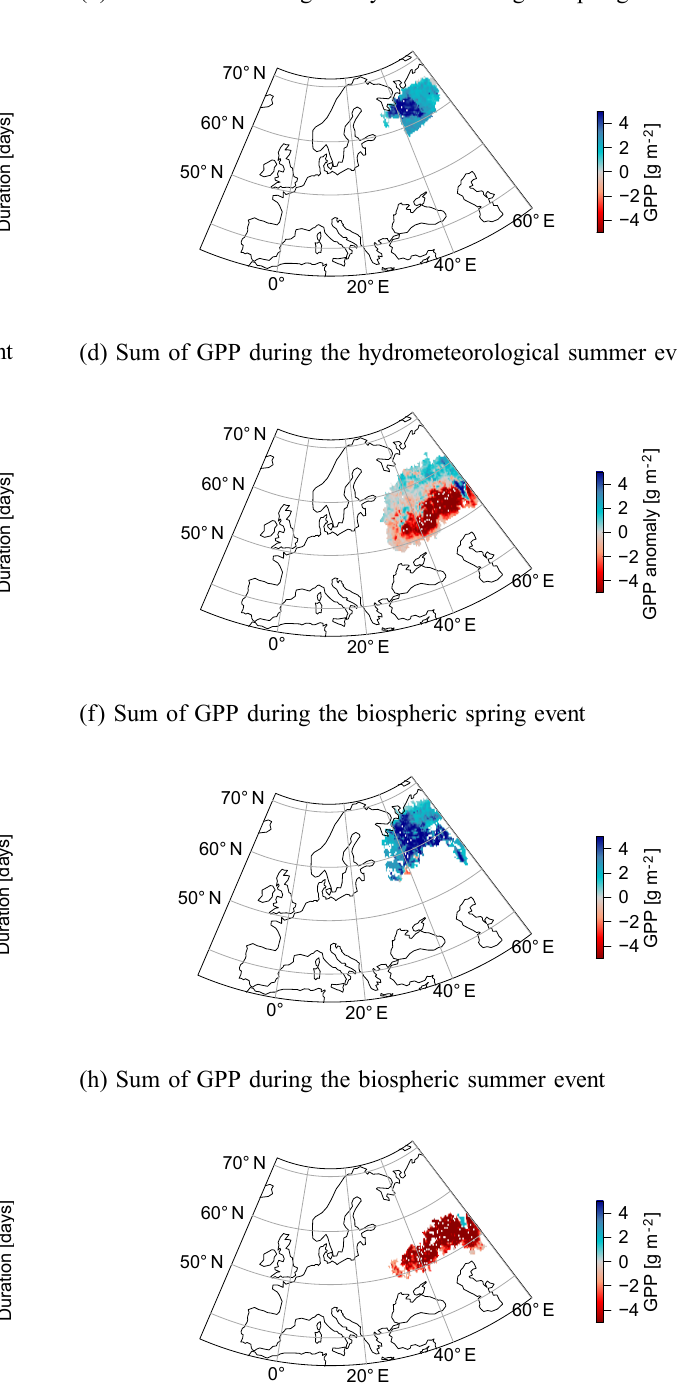
Figure 5. Left column: temporal duration of the (a) hydrometeorological spring event, (c) hydrometeorological summer event, and biospheric 1 events (e, g) . Right column: corresponding GPP response, i.e., the sum of deviations from the seasonal cycle during the event for the (b) hydrometeorological spring event, (d) hydrometeorological summer event, and biospheric events (f, h) . While the GPP response during the hydrometeorological spring event is entirely positive (more productive than usual, b ), GPP response during the hydrometeorological summer event differs between higher latitudes ( > 55 ◦ N, short-lasting, positive) and lower latitudes (long-lasting,